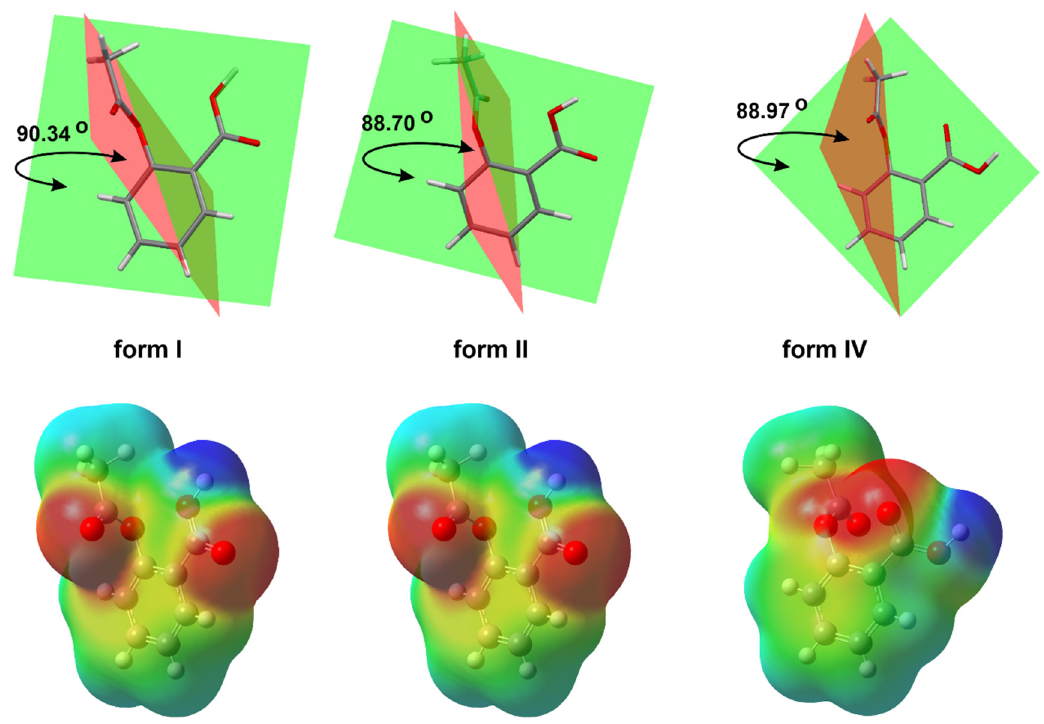
Figure 1. The basic crystal structure of ASA (CSD refcode ACSALA); compared 3D molecular view of the forms, I (CSD refcode ACSALA), II (CSD refcode ACSALA13) and IV (CSD refcode ACSALA24); the orientation of OH moiety with respect to the Ac group is on the near side in form I and II, but in form IV, we can observe the inverse arrangement of mentioned moieties; calculated molecular electrostatic potential map of ASA forms.